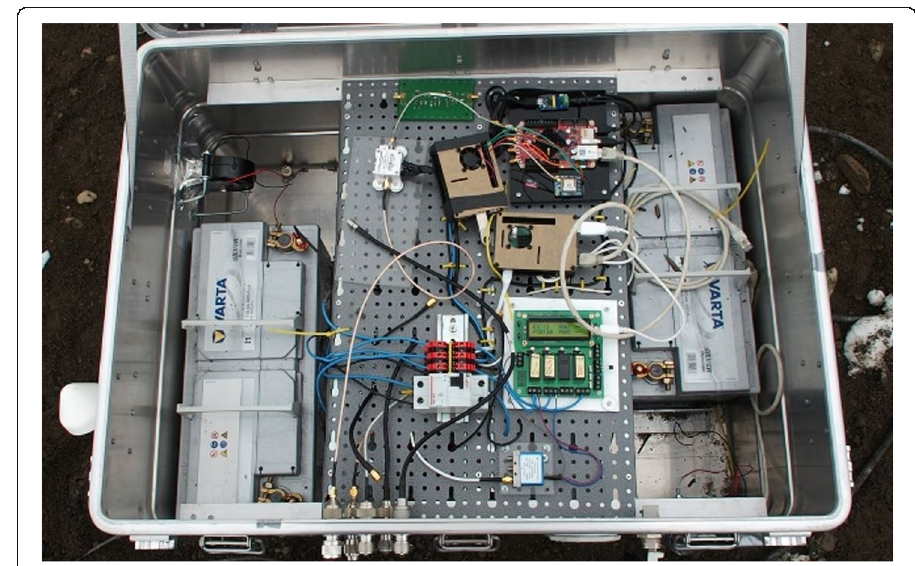
Fig. 20 NVIS remote node installed in Argentina Cove. Installation of a remote node in the Antarctica scenario. This node was situated 2 km away from the central